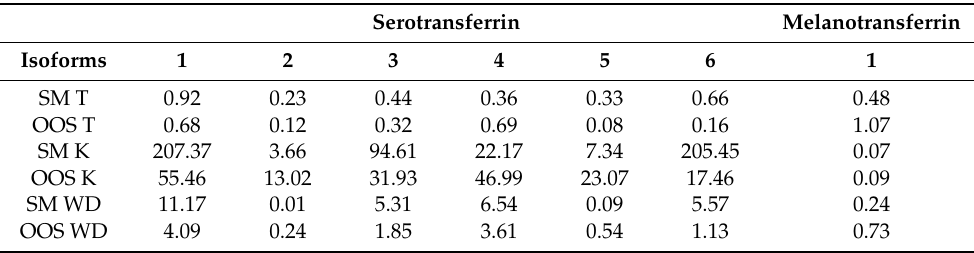
Table 2. Relative abundances (TPM) of the sterlet serotransferrin and melanotransferrin isoforms in the studies samples.